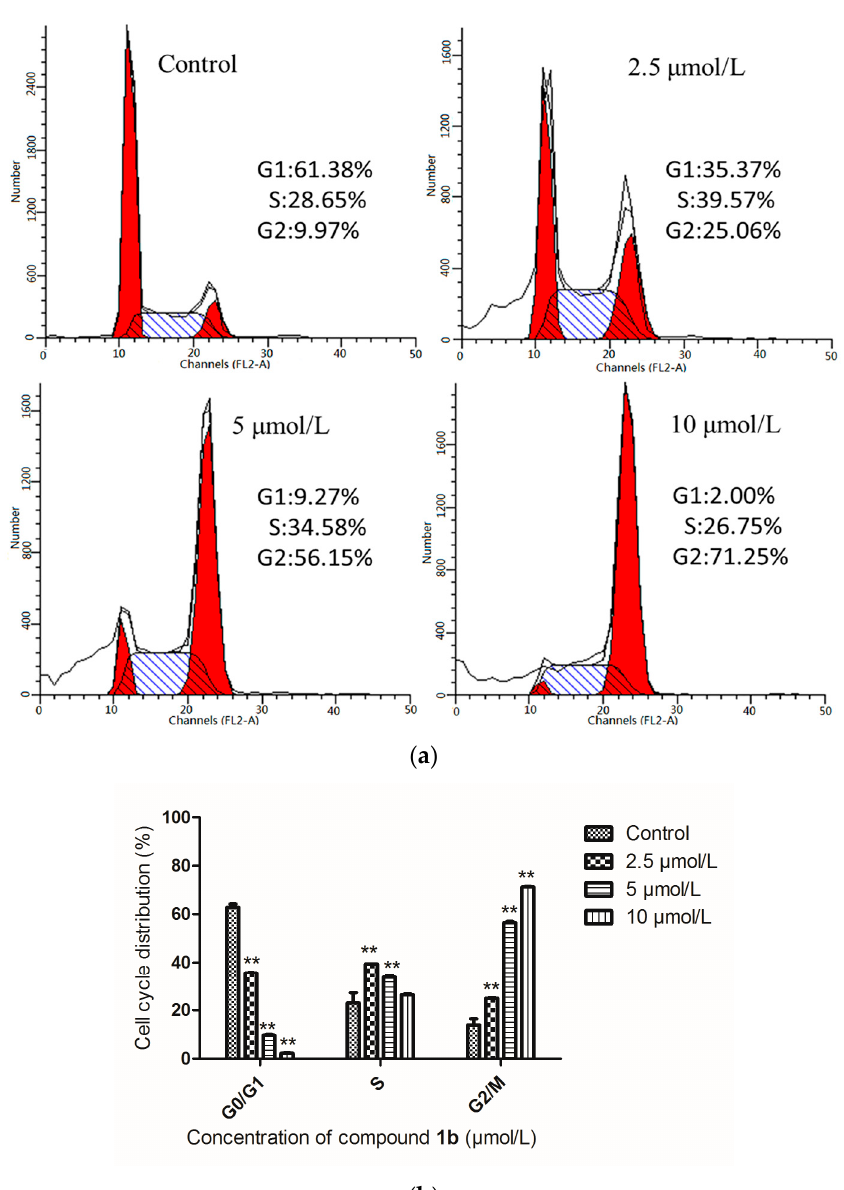
Figure 3. ( a ) Effects of compound 1b on the cell cycle progression of HepG-2 cells were determined by flow cytometry analysis. HepG-2 cells were treated with different concentrations of compound 1b for 24 h. The percentage of cells in each cycle phase is indicated (left red for G1, center shadow for S, light red for G2); ( b ) Cell cycle distribution of HepG-2 cells. Compared with the corresponding control group, ** p < 0.01, ( n = 3).